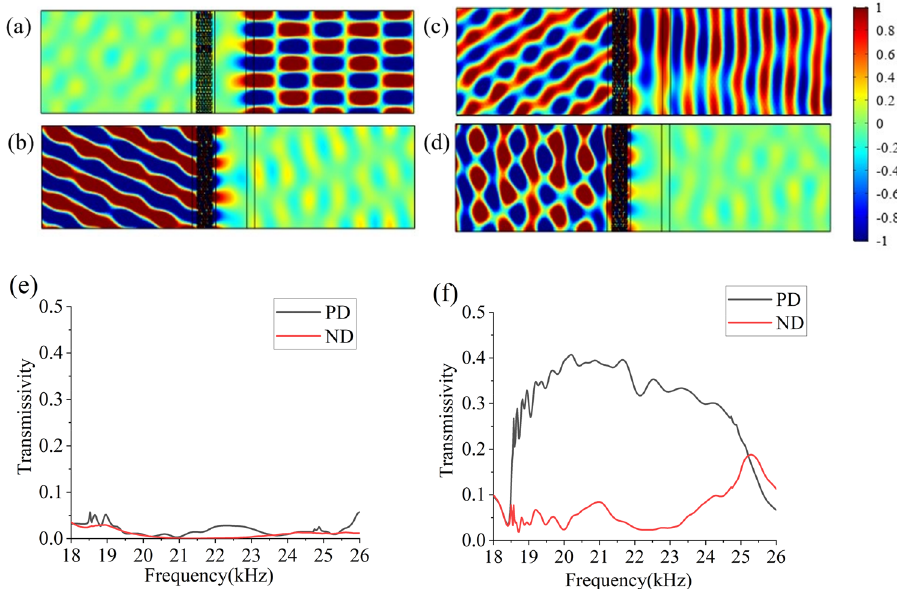
Figure 6. ( a–d ) Spatial distribution of the acoustic pressure generated by the oblique incident waves at 20 kHz: ( a,b ) incident angle of 60° in PD and ND; ( c,d ) incident angle of 3° in PD and ND. ( e,f ) Curves of transmissivity with frequency at 60° and 3°, the black and the red lines indicate the PD transmissivity and ND transmissivity